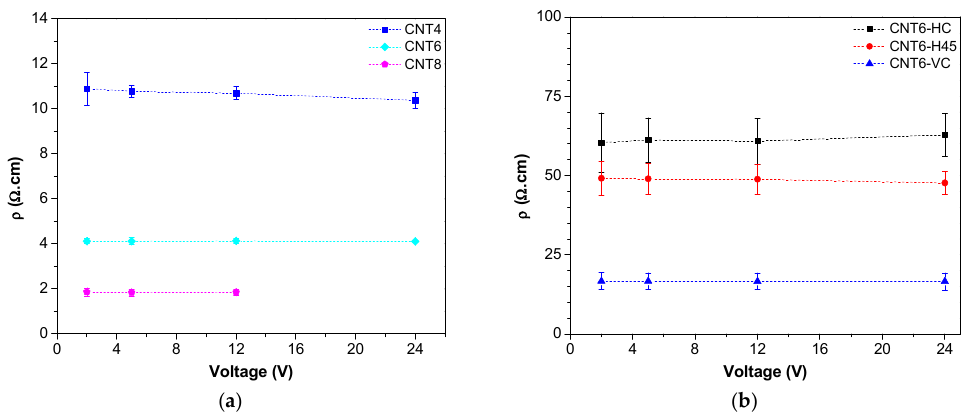
Figure 13. Electrical resistivity of ABS nanocomposites: ( a ) filament and ( b ) 6 wt % filled nanocomposites with different 3D printing as a function of the applied voltage.